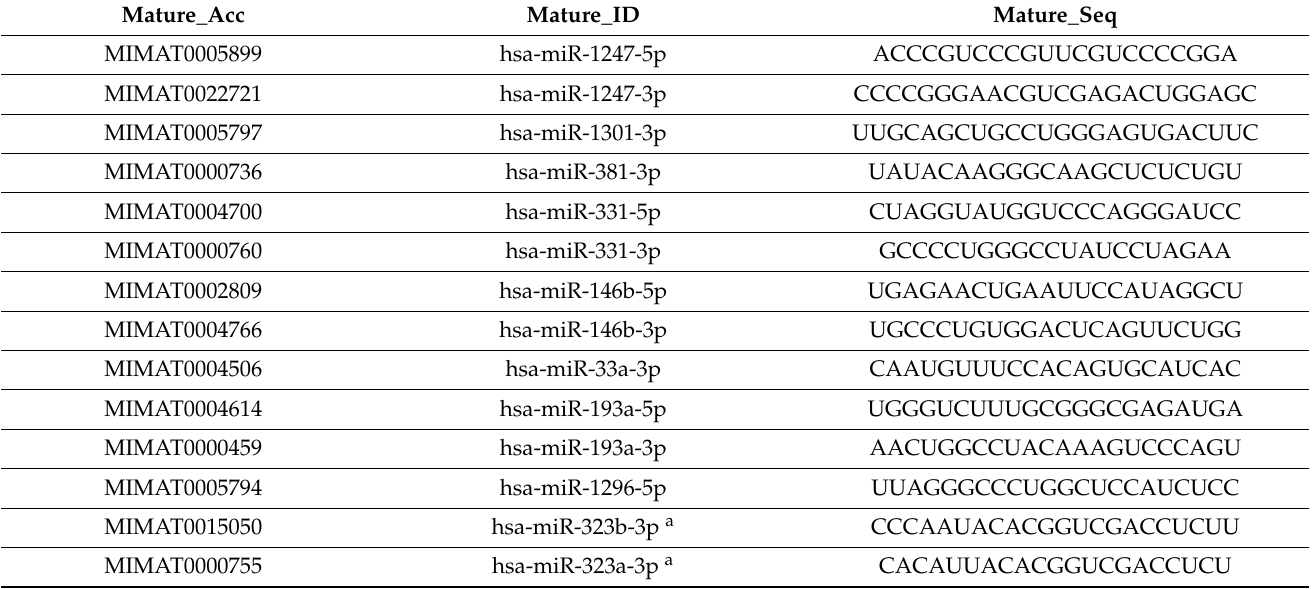
Table 2. miRNA candidates for in vitro validations and their miRBase annotation, Homo sapiens (hsa) miRNA, release